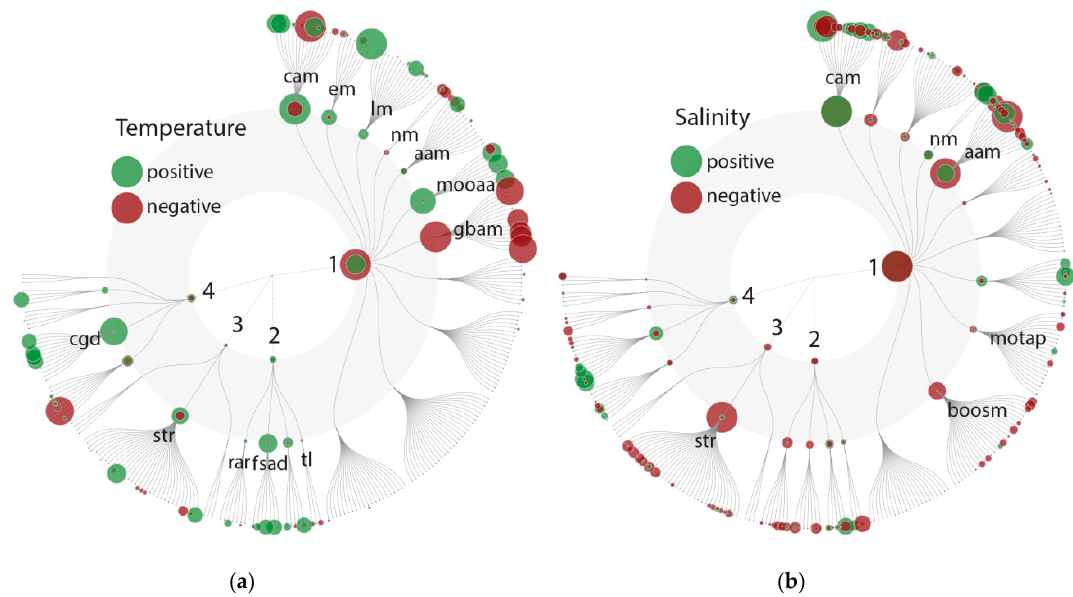
Figure 4. FuncTree 2 plot: positive (green) or negative (red) correlation with Pfam domains depicting variability most likely related to changes in temperature ( a ) and salinity ( b ). The KEGG biologic categories are metabolism (1) : carbohydrate metabolism (cam), energy metabolism (em), lipid metabolism (lm), nucleotide metabolism (nm), amino acid metabolism (aam), metabolism of other amino acids (mooaa), gylcan biosynthesis and metabolism (gbam), metabolism of terpenoids and polyketides (motap), biosynthesis of other secondary metabolites (boosm); and genetic information processing (2) : replication and repair (rar), folding, sorting and degradation (fsad) and translation (tl); environmental information processing (3) : signal transduction (str); and cellular processes (4) : cell growth and death (cgd). More details on the KEGG categories can be found in Figure 5. KEGG Orthology (KO) abundance was counted and plotted (size = relative abundance of KOs).